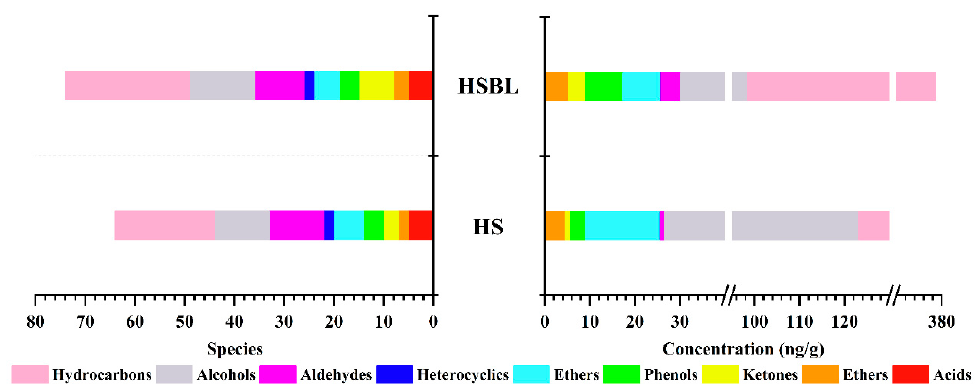
Figure 2. The accumulation diagram of aroma compounds of Hotpot seasoning before and after boiling. after